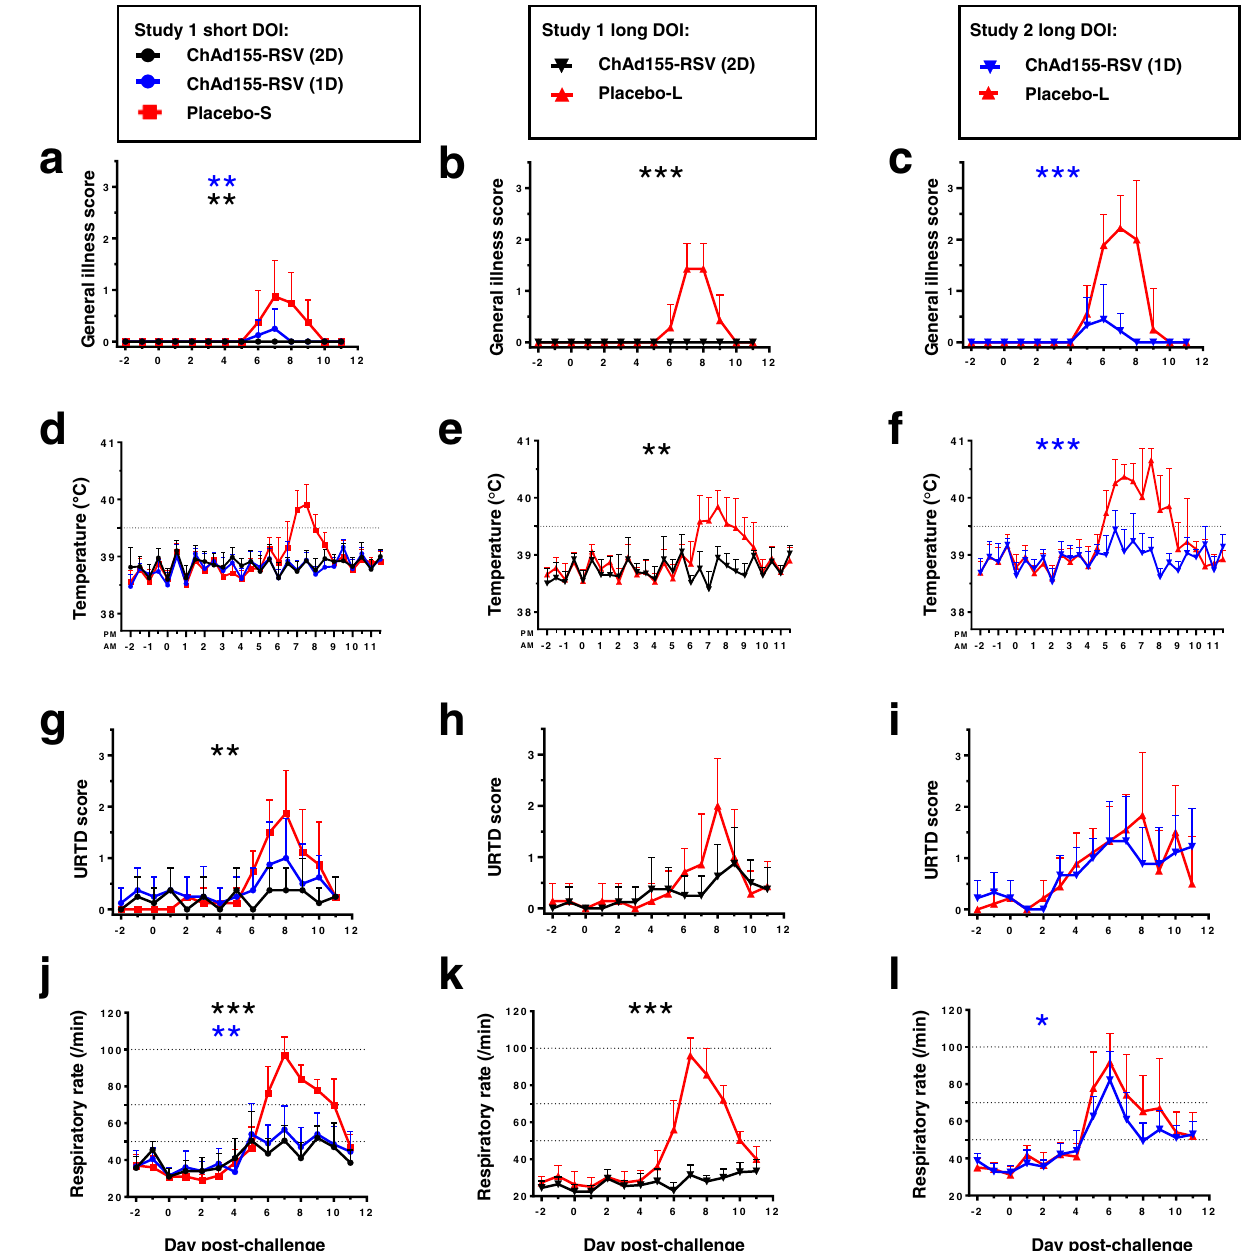
Fig. 2 | Clinical symptoms. Calves ( n =7 – 9 biologically independent animals, see Table 1) received either a single or two doses (1D or 2D, respectively) of ChAd155- RSVvaccineorplacebo,followedbyashort(4weeks)orlong(16weeks)durationof immunity (short DOI or long DOI, respectively), and then a bovine RSV challenge. Placebo-Sandplacebo-Lgroupsindicatethecontrolgroupssubjectedtotheshort- DOI and long-DOI regimens, respectively (note that the sample size [ n =9] of the placebo-LgroupofStudy2decreasedto n =5ondaypost-challenge[dpc]8,andto n =4ondpc9 – 11;see Fig.3). Clinicalsymptomsinthe ChAd155-RSV-immunizedor placebo-treated calves were evaluated according to the scoring system presented